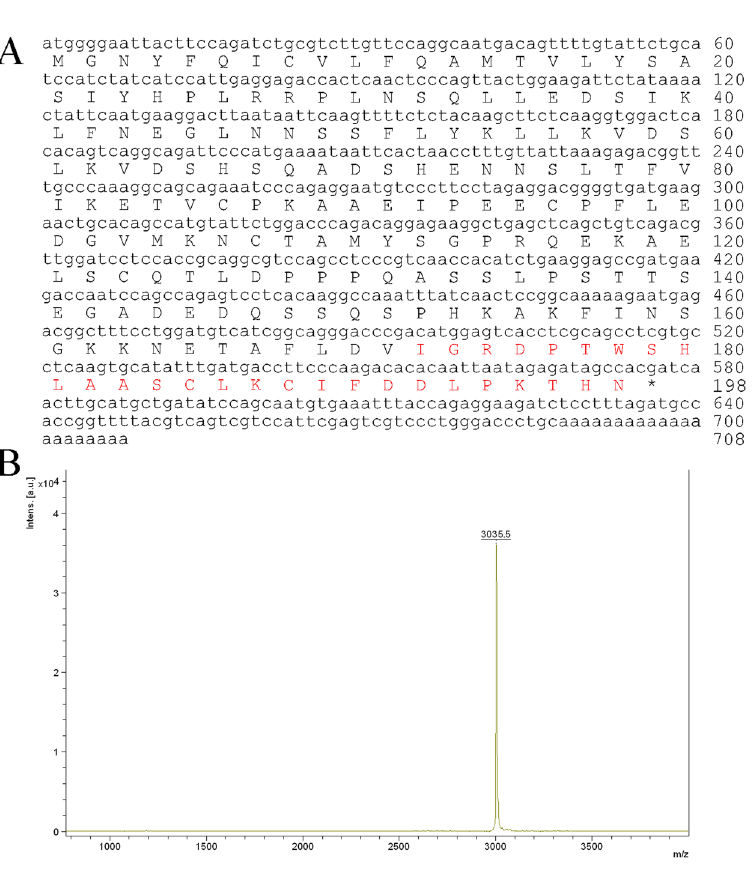
Figure 2. Primary structure of cathelicidin-OA1. ( A ) cDNA sequence of cathelicidin-OA1. The mature peptide (‘IGRDPTWSHLAASCLKCIFDDLPKTHN ′ ) was 27 amino acid residues in length (red), and was produced by posttranslational processing of a 198-residue prepropeptide. ( B ) Observed molecular mass of cathelicidin-OA1 (indicated by an arrow in Fig.